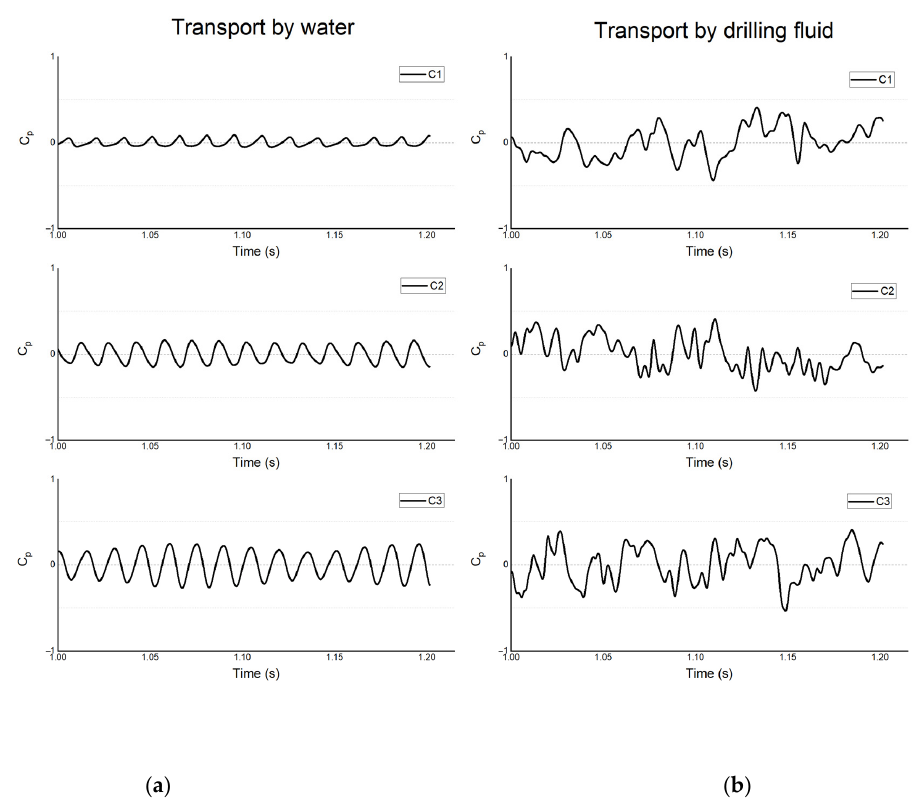
Figure 11. Pressure coefficients at the different points on the volute spacer tongue (C1–C3). ( a ) Water case; ( b ) drilling-fluid case.